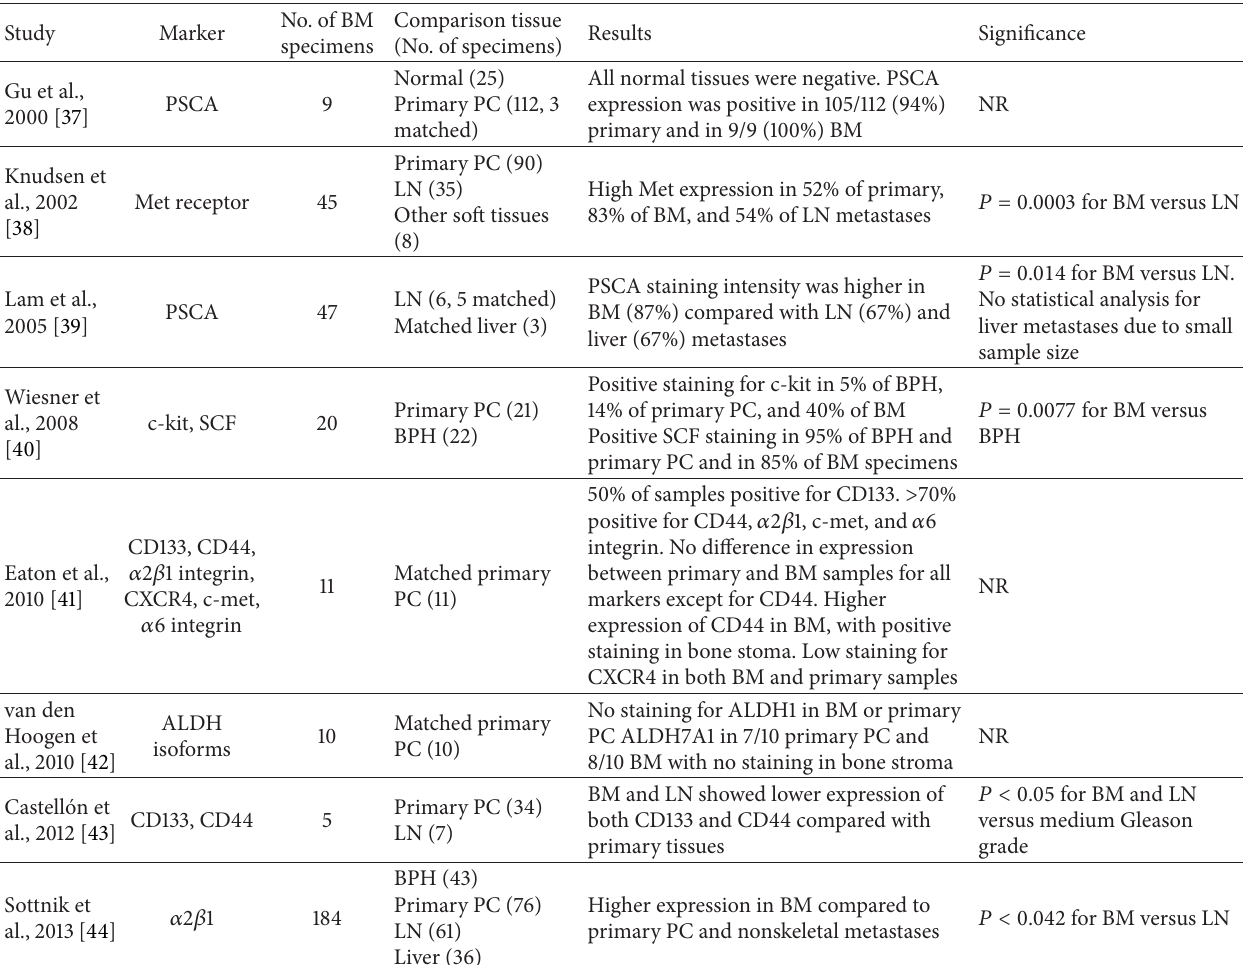
Table 2: Details of studies analysing expression of stem cell markers in PC bone